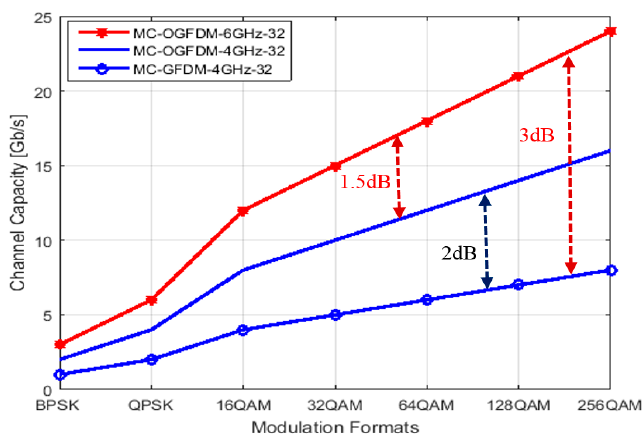
Figure 6. Channel capacity of the multi-carrier OGFDM vs. generalized frequency division multiplexing (GFDM) with F DAC = 4 and 6 GHz.